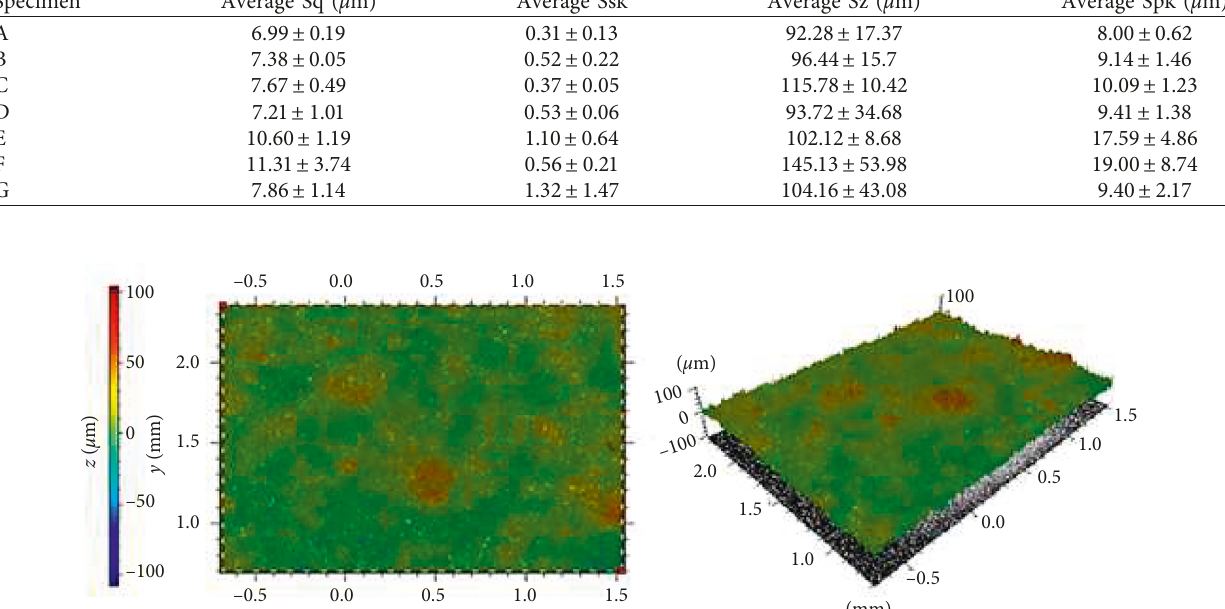
Figure 4: Two- and three-dimensional view of the NiTinol coating’s surface observed with the light